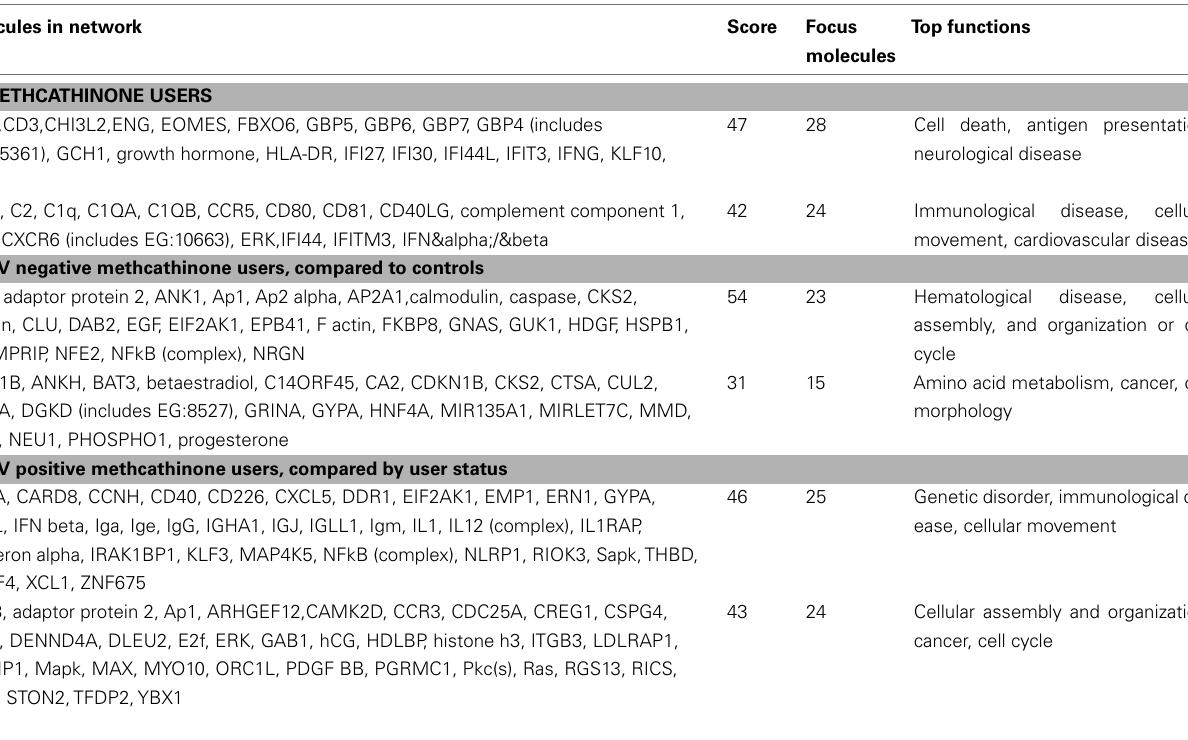
Table 3 | Genetic networks significantly